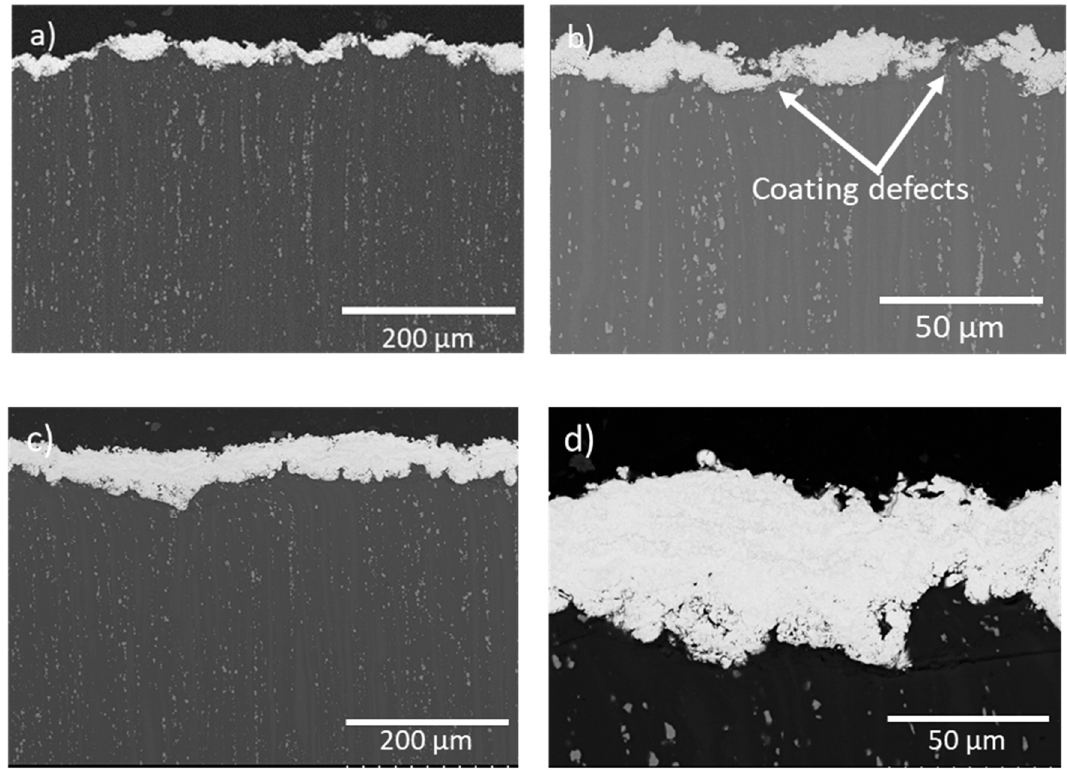
Figure 4. SEM micrographs of the cross section of ( a ) 1L-1 sample, ( b ) detailed view of 1L-1 coating, ( c ) 2L-1 sample and ( d ) detailed view of 2L-1 coating.